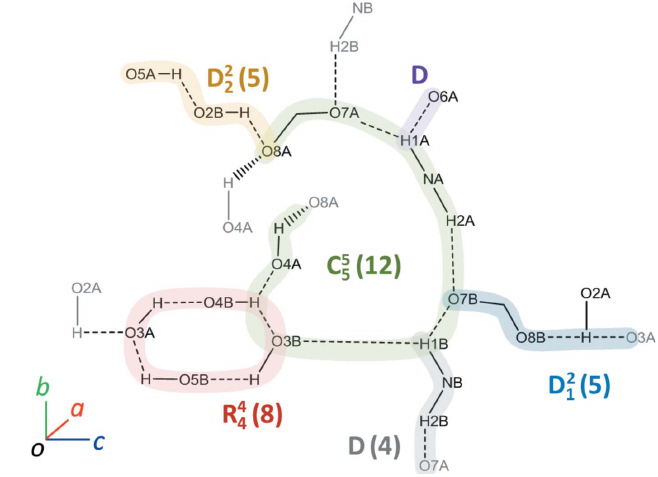
Figure 5 Hydrogen-bond patterns in the crystal structure of (I).